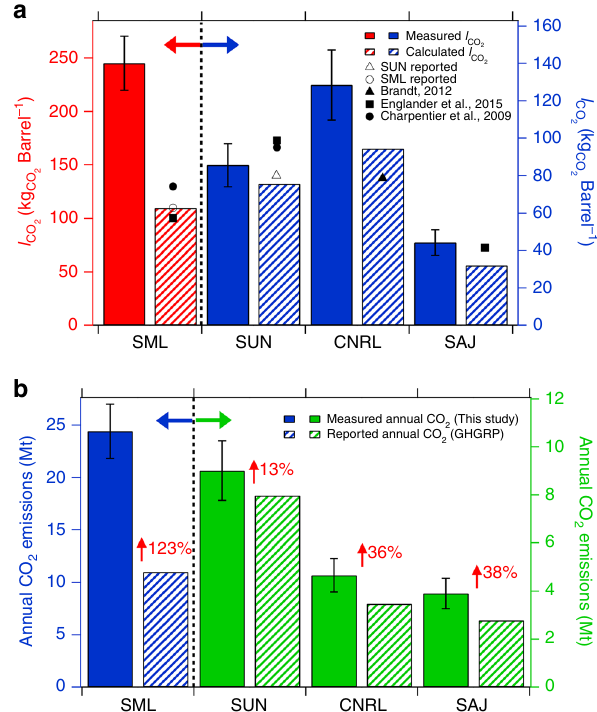
(cid:3) (cid:4) p for the multiple fl ights over a facility. Map N